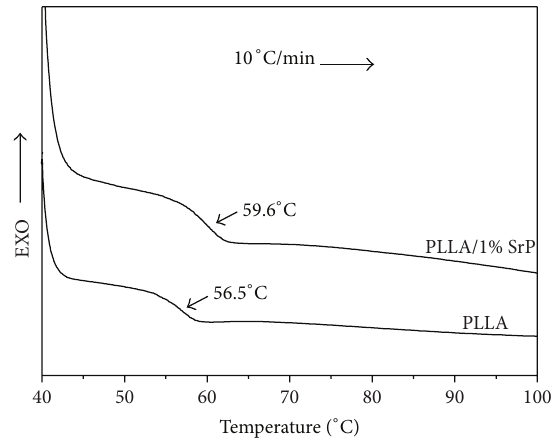
Figure 7: XRD curves of PLLA and PLLA/SrP after nonisothermal crystallization.